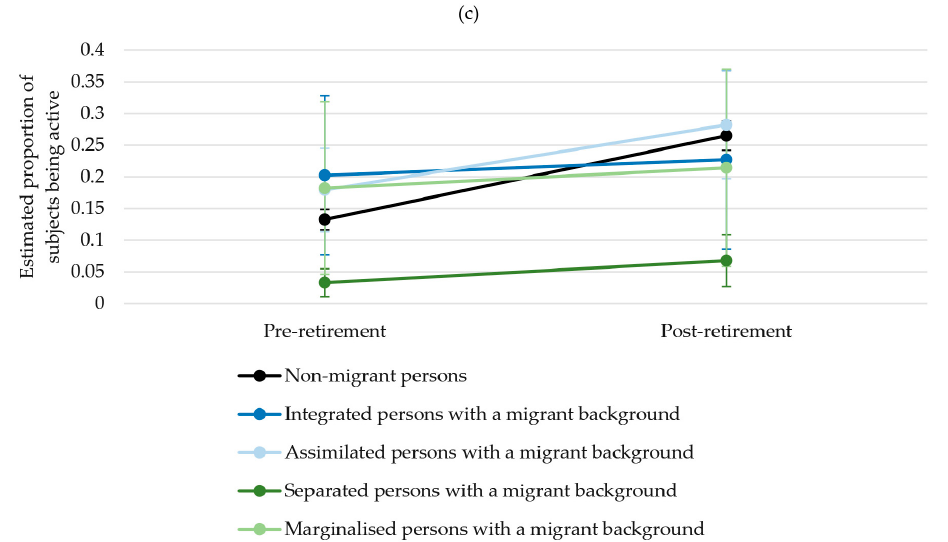
Figure 3. Estimated proportions of subjects participating in sports by retirement status adjusted for sex, age at retirement, SES, health status and BMI (marginal means with 95% CIs) for ( a ) Acculturation in terms of language; ( b ) Acculturation in terms of social interaction; ( c ) Acculturation in terms of